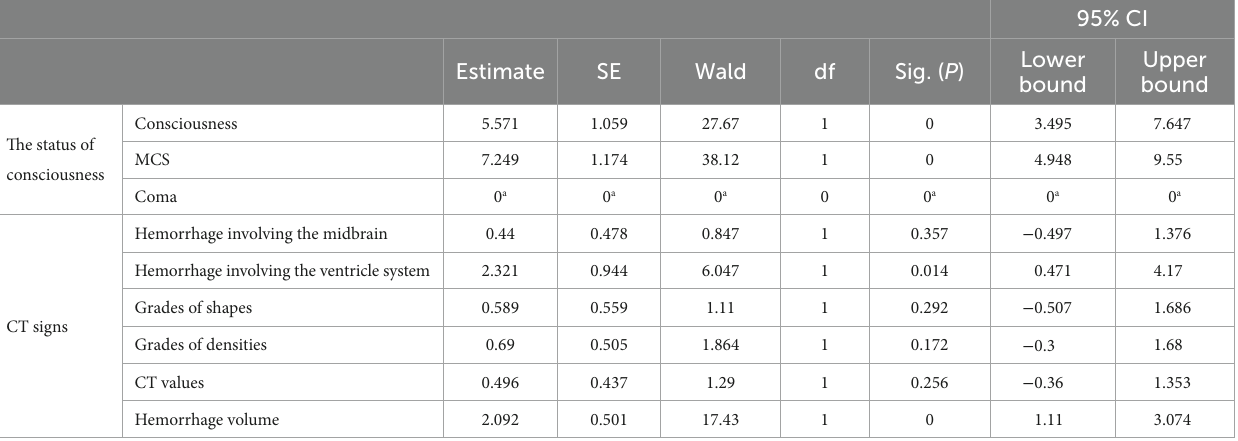
TABLE 3 Order-based multi-class categorical logistic analysis on the CT signs of patients with primary brainstem hemorrhage (PBH) to indicate the status of